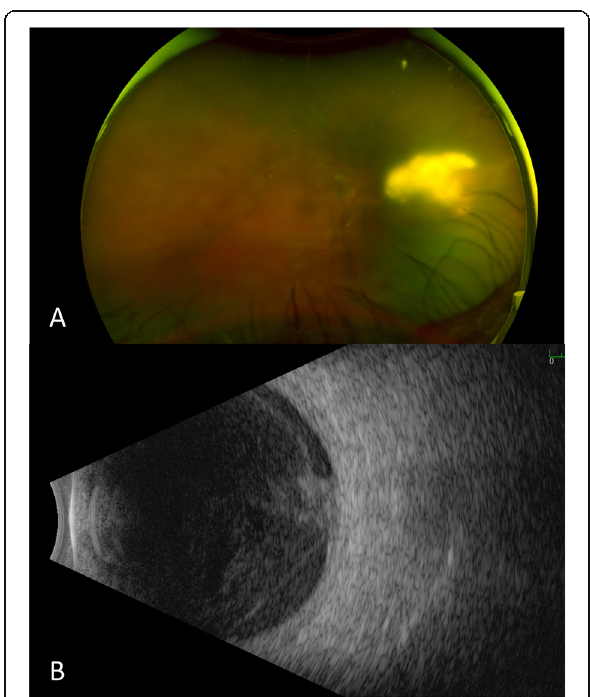
Fig. 1 a Fundus photo and b B-scan showing a vitreous mass with white debris extending inferiorly concerning for endogenous